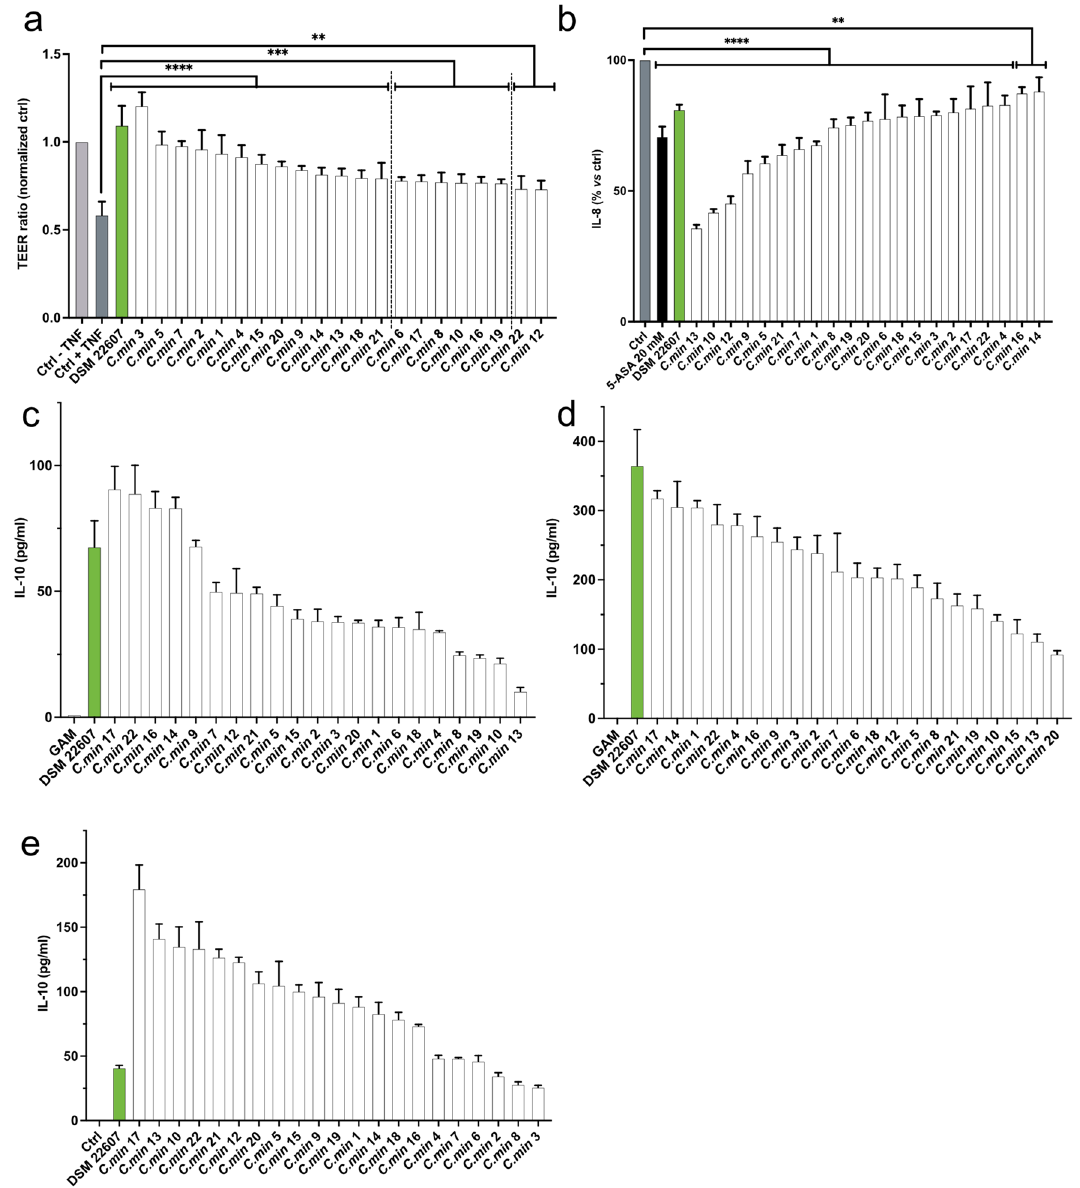
Figure 2. STEP 1 in vitro screening results: ( a ) Evaluation of the effects of our strains on intestinal barrier by measuring transepithelial electrical resistance (TEER). The polarized Caco-2 monolayers were challenged with TNF-α to disrupt the intestinal barrier. Statistics : one-way ANOVA followed by Dunnett’s multiple comparisons test (**** p < 0.0001; *** p = 0.0005 for C. min 6, p = 0.0008 for C. min 8, p = 0.0003 for C. min 10 and 16, p = 0.0001 for C. min 17 and p = 0.0004 for C. min 19; ** p = 0.0073 for C. min 12 and p = 0.0063 for C. min 22). ( b ) Evaluation of the anti-inflammatory properties on a human-derived intestinal cell line (HT-29) stimulated with TNF-α. Statistics : one-way ANOVA followed by Dunnett’s multiple comparison test: ****p < 0.0001, **p = 0.0029 for C. min 16 and p = 0.0059 C. min 14. 5-ASA 20 mM was used as a positive control. ( c – e ) IL-10 production by human-derived PBMCs on three different donors. No statistics were performed for this assay since we considered that any production of IL-10 was a positive response. Key : Ctrl Control with culture medium, DSM 22607 C. minuta DSM